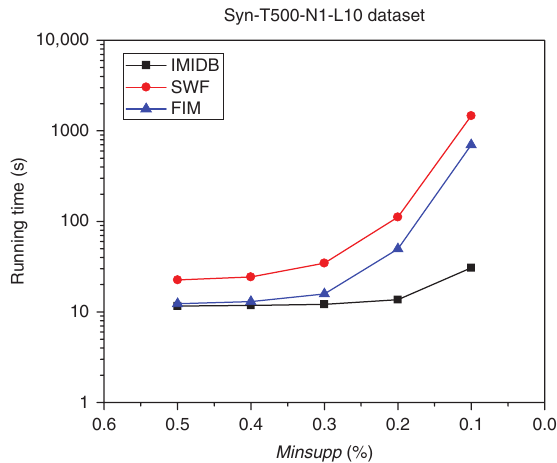
Figure 12: Running Time Comparison – Syn-T500,N1,L10 Dataset.